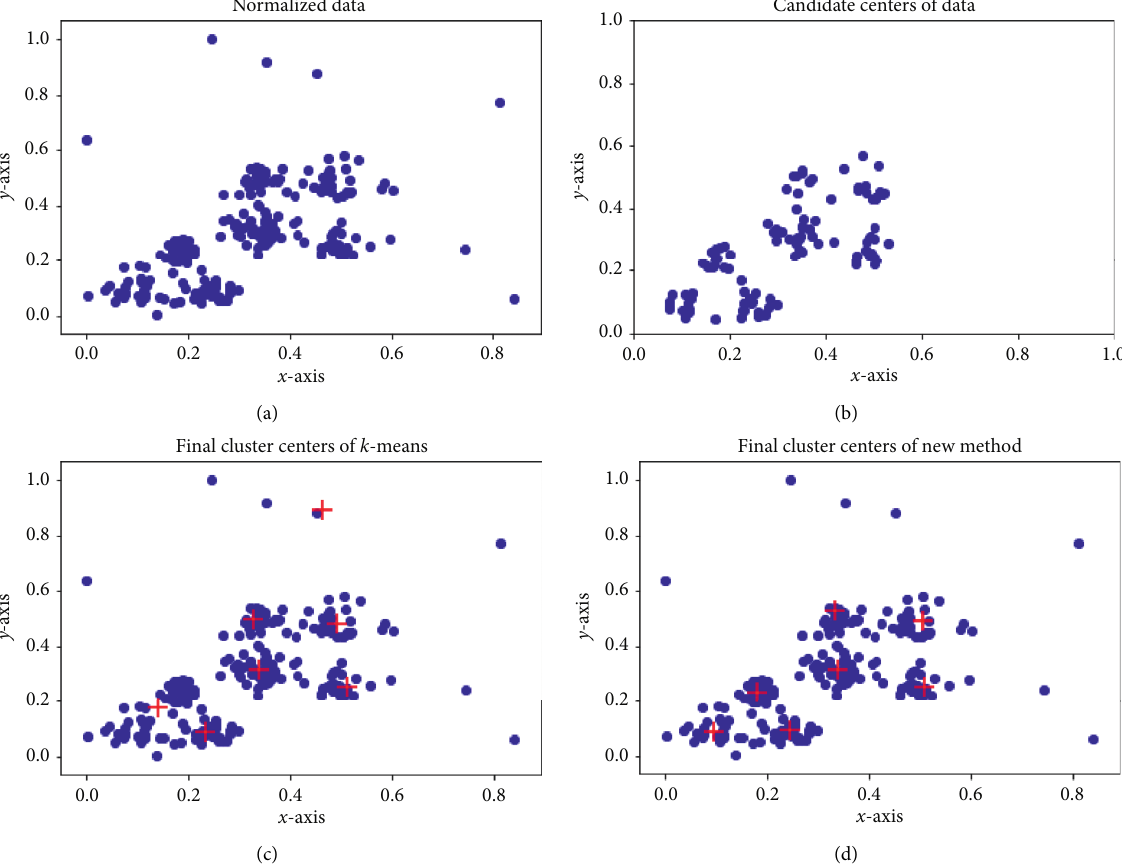
Figure 2: Experimental results on synthetic data set #2 (the red ‘+’s are the cluster centers). (a) Normalized data. (b) Selected subset. (c) Clustering centers of k -means algorithm. (d) Clustering centers of our proposed